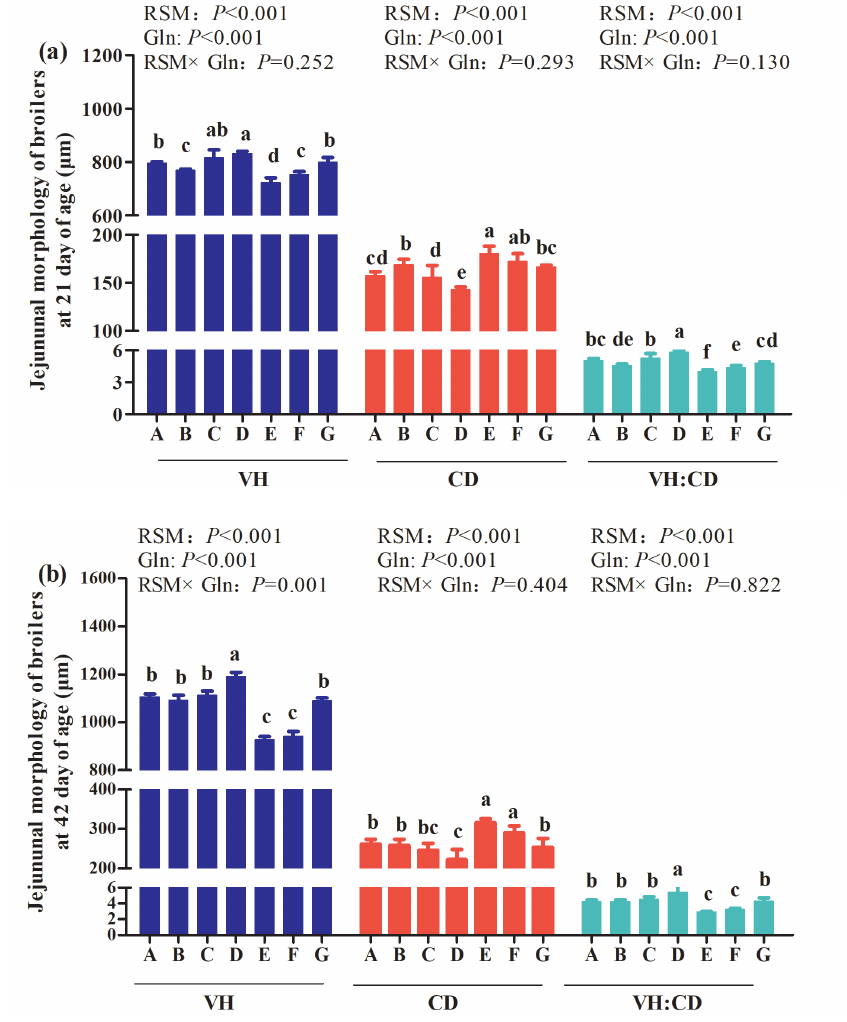
Figure 1. Effects of different levels of rapeseed meal substitution and glutamine on jejunum morphology of Qiandongnan Xiaoxiang Chicken at 21 and 42 days of age (n = 10 per treatment group). Columns in the same color with different small letters superscripts mean significant differences (p<0.05). Broilers in the control group (A) were fed with basal diet. Broilers in 10% (B) and 20% RSM (E) were fed with diet containing 10% or 20% RSM, respectively. 10% RSM+0.5% Gln (C), 10% RSM+1.0% Gln (D), 20% RSM+0.5% Gln (F), and 20% RSM+1.0% Gln (G) mean that 0.5% Gln or 1% Gln was separately supplemented based on 10% and 20% RSM